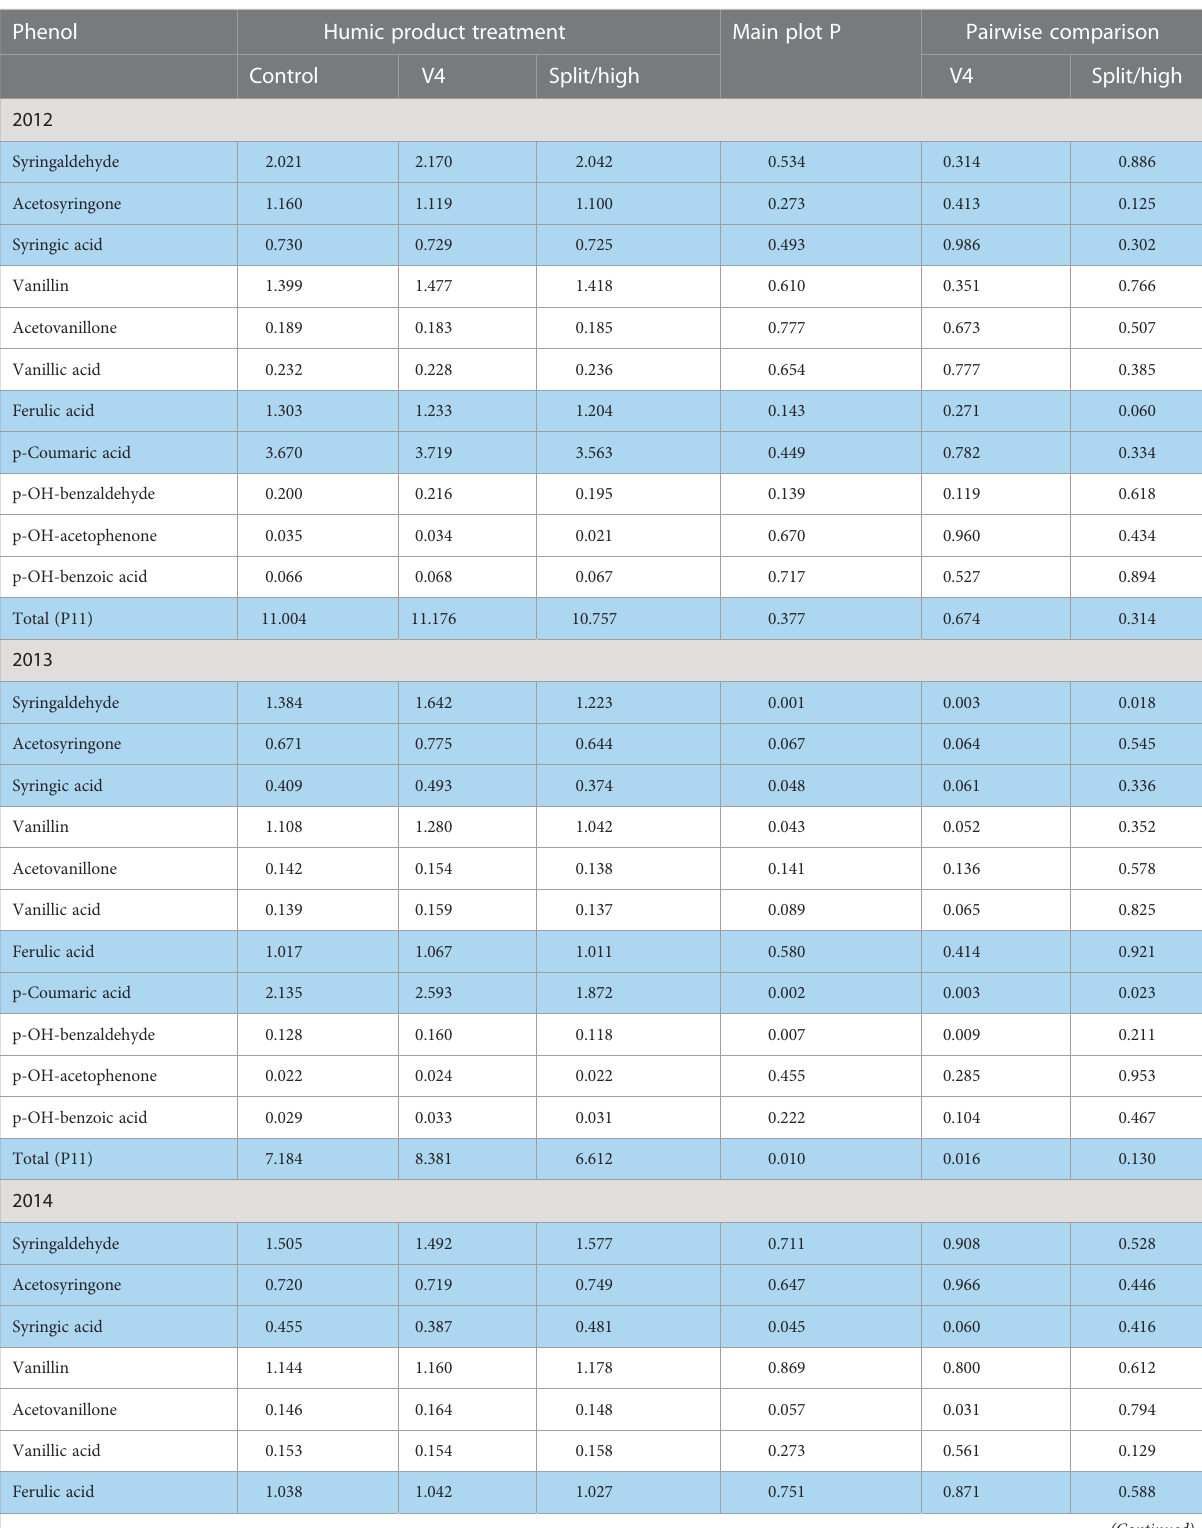
Phenol Humic product treatment Main plot P Pairwise comparison Control V4 Split/high V4